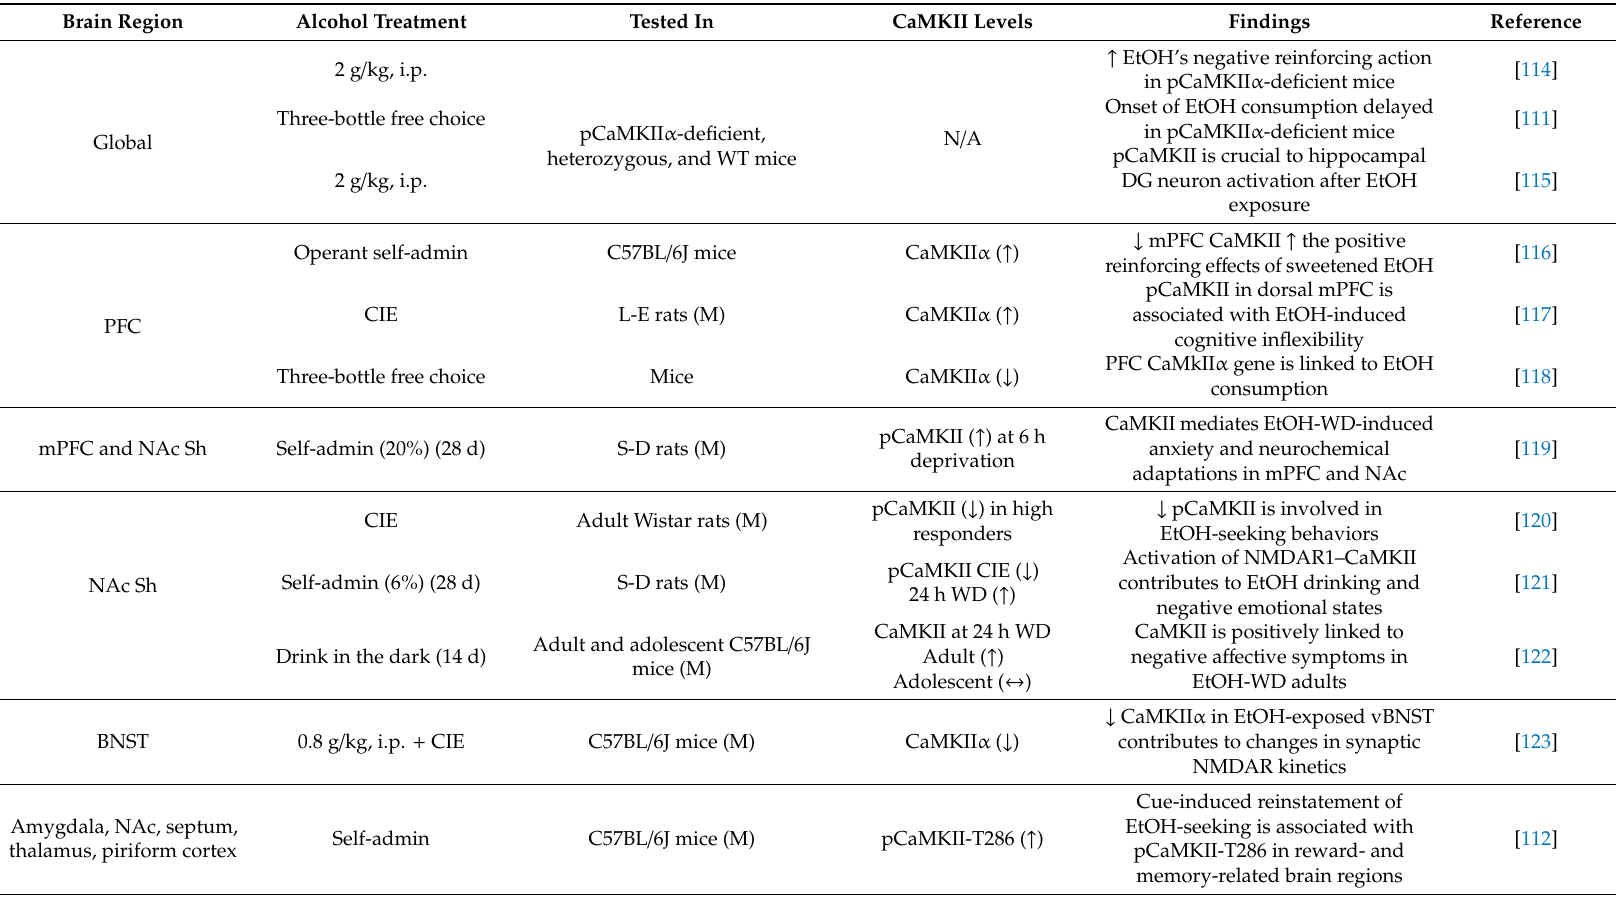
Table 1. Evidence on CaMKII in alcohol use disorders and its